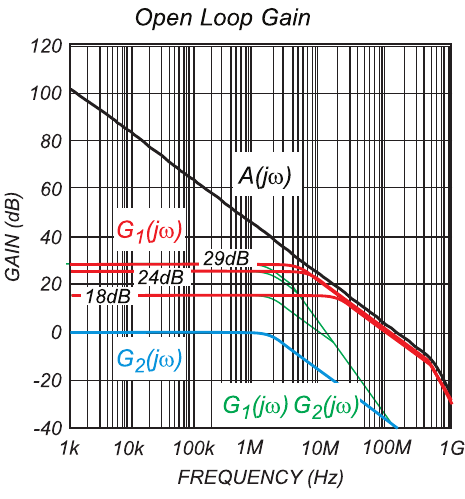
and sink temperature # DS